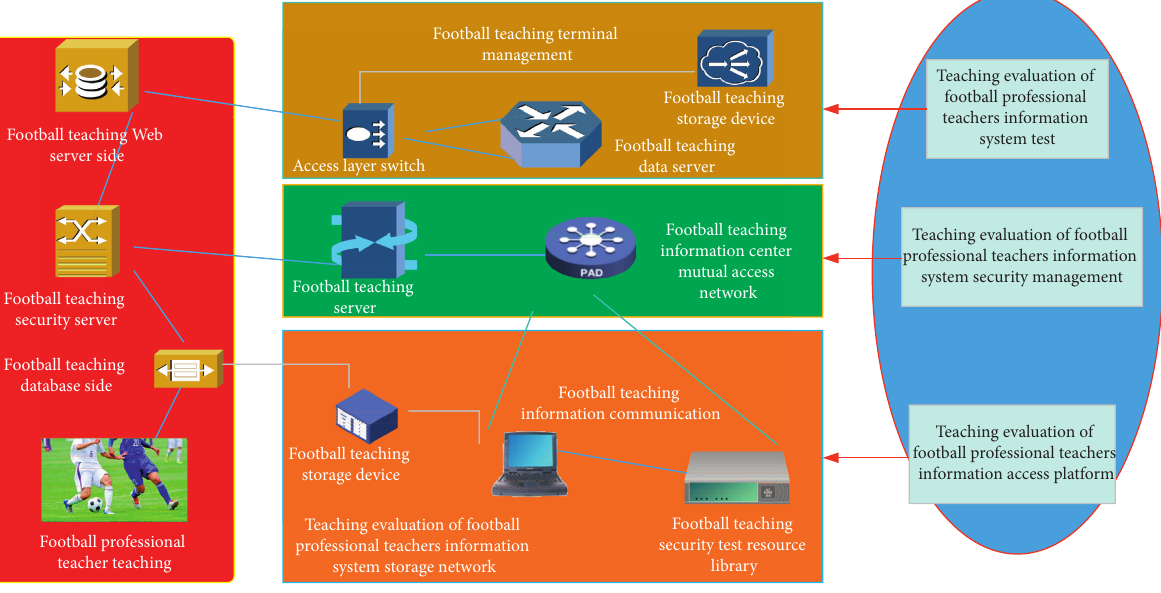
Figure 1: Design of football teaching